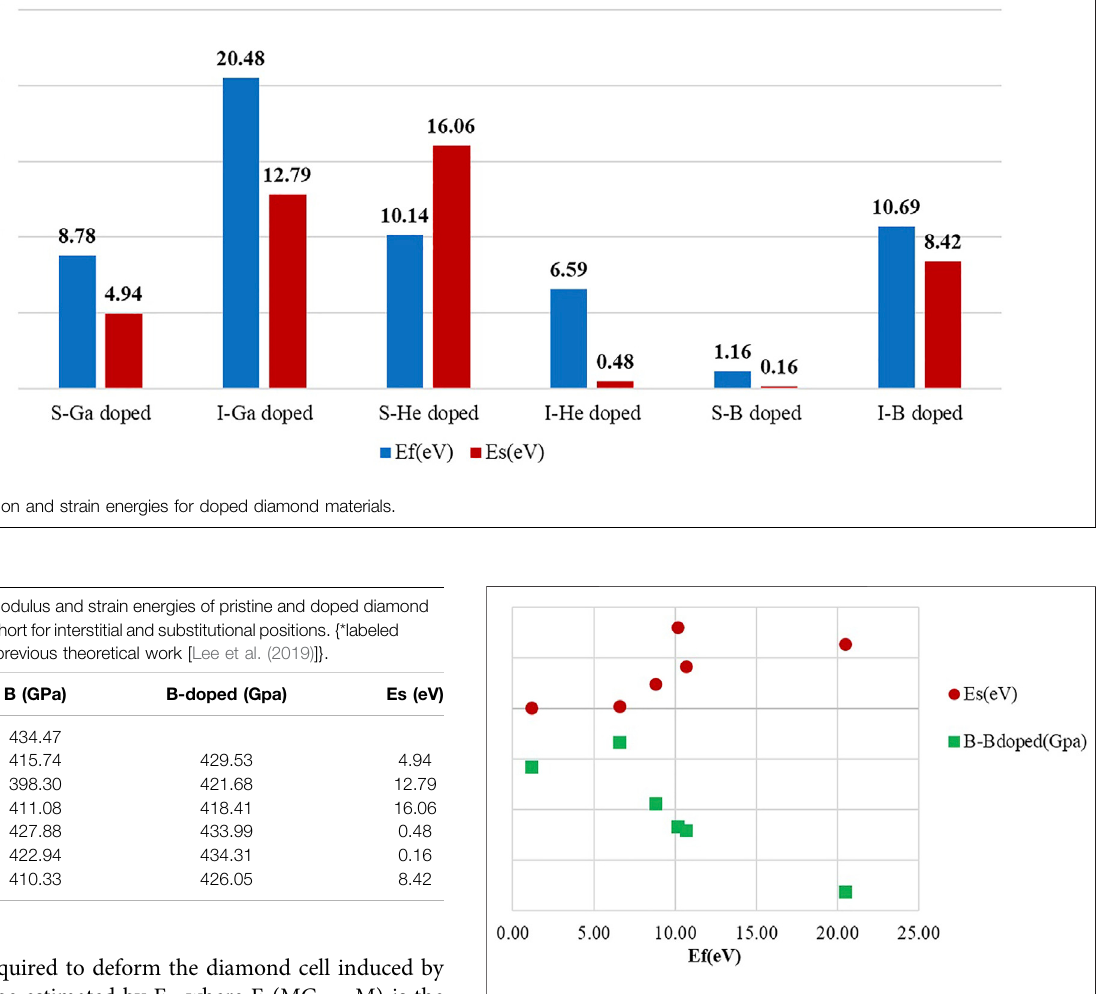
FIGURE 4 | Strain energies and the reduction of bulk modulus for diamond with different